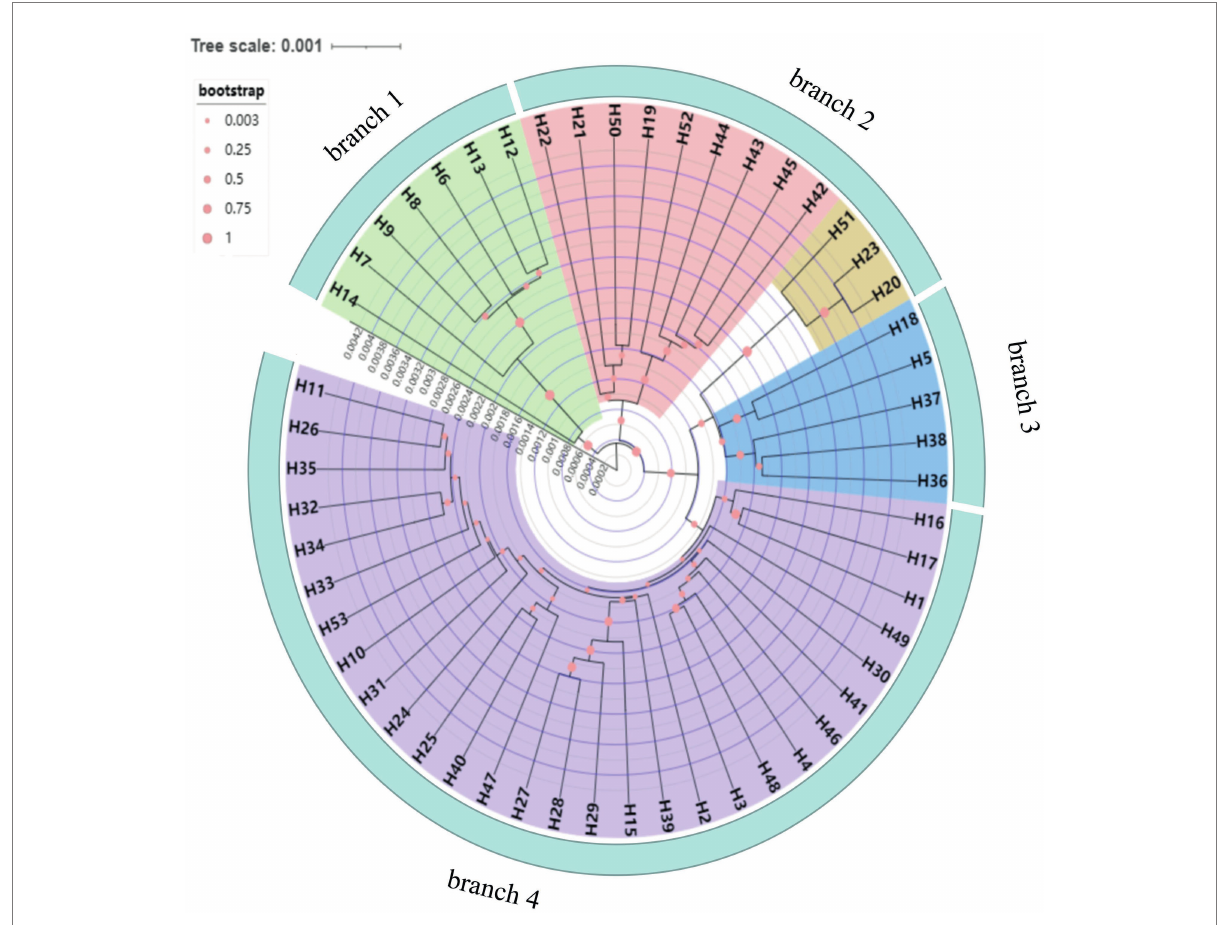
FIGURE 9 Neighbor-Joining (NJ) dendrogram of the 53 cpDNA haplotypes of the test